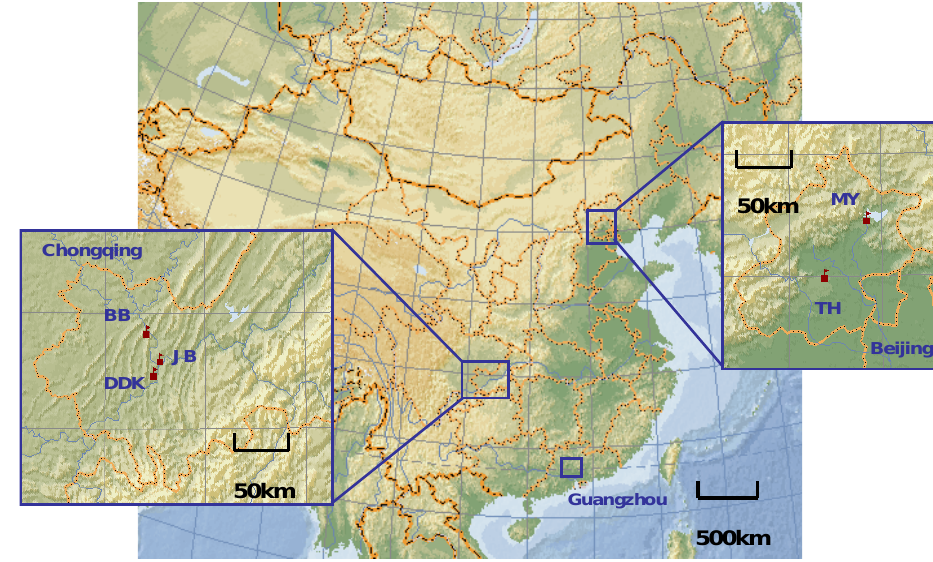
Fig. 1. Sampling sites in Beijing (TH and MY), Chongqing (JB, DDK, and BB), and Guangzhou (Wushan). The topography map was derived from the Microsoft Encarta 2009©